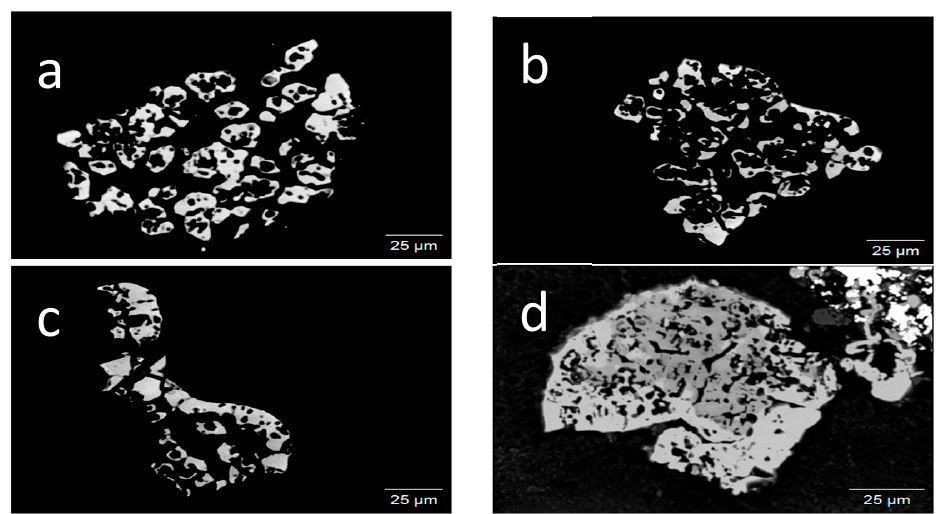
Figure 3. BSE images of a polished section, showing two-dimensional cross-sections through siderazot aggregates. Small spheres with central cavities ( a – c ) occur beside a less porous species ( c , d ). The aggregate in ( d ) contains a core of a dark gray Na-, Fe-, N-, and O-bearing phase, rimmed by the middle gray siderazot. The white phase in the upper right is baryte, associated with siderazot, and very dark gray K-feldspar.